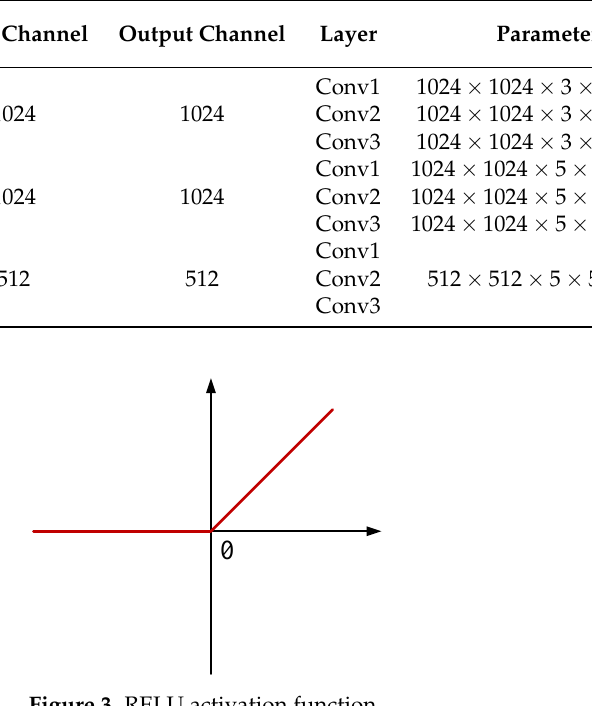
Figure 3. RELU activation